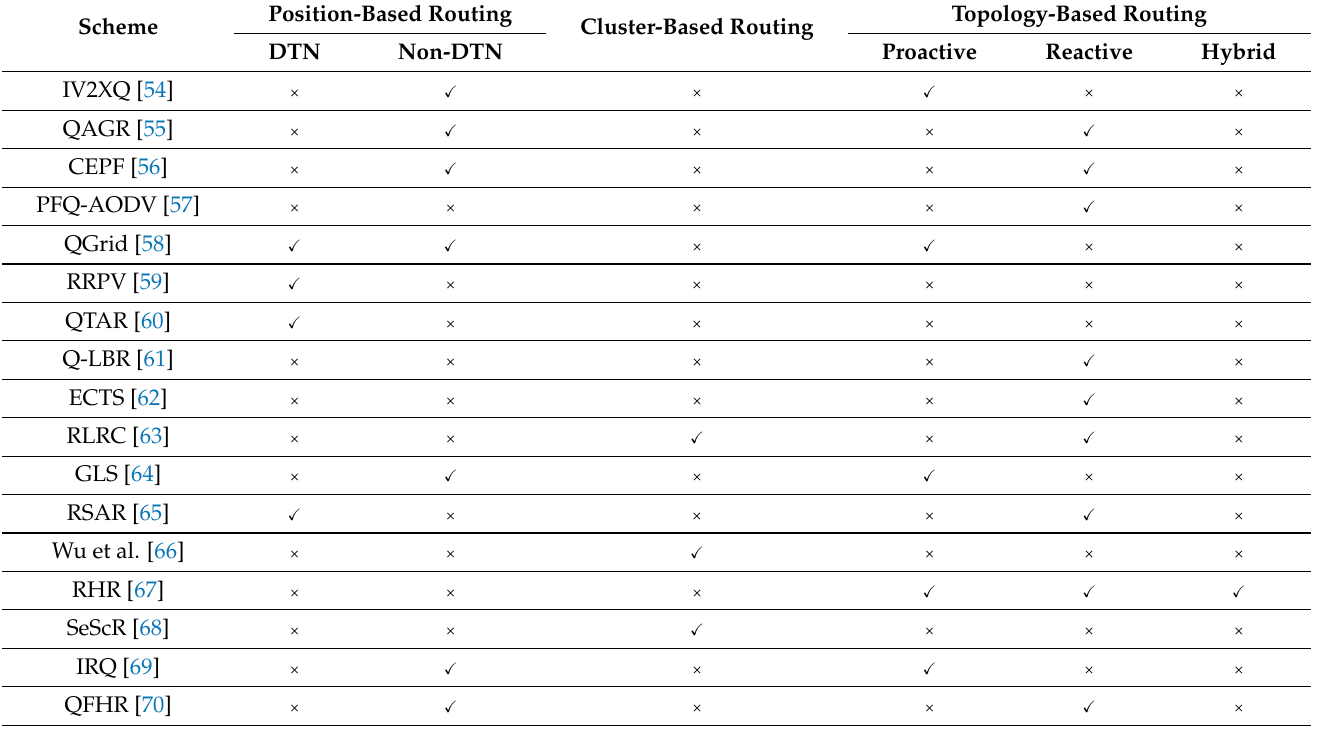
Table 16. Comparison of RL-based routing methods in terms of routing techniques.